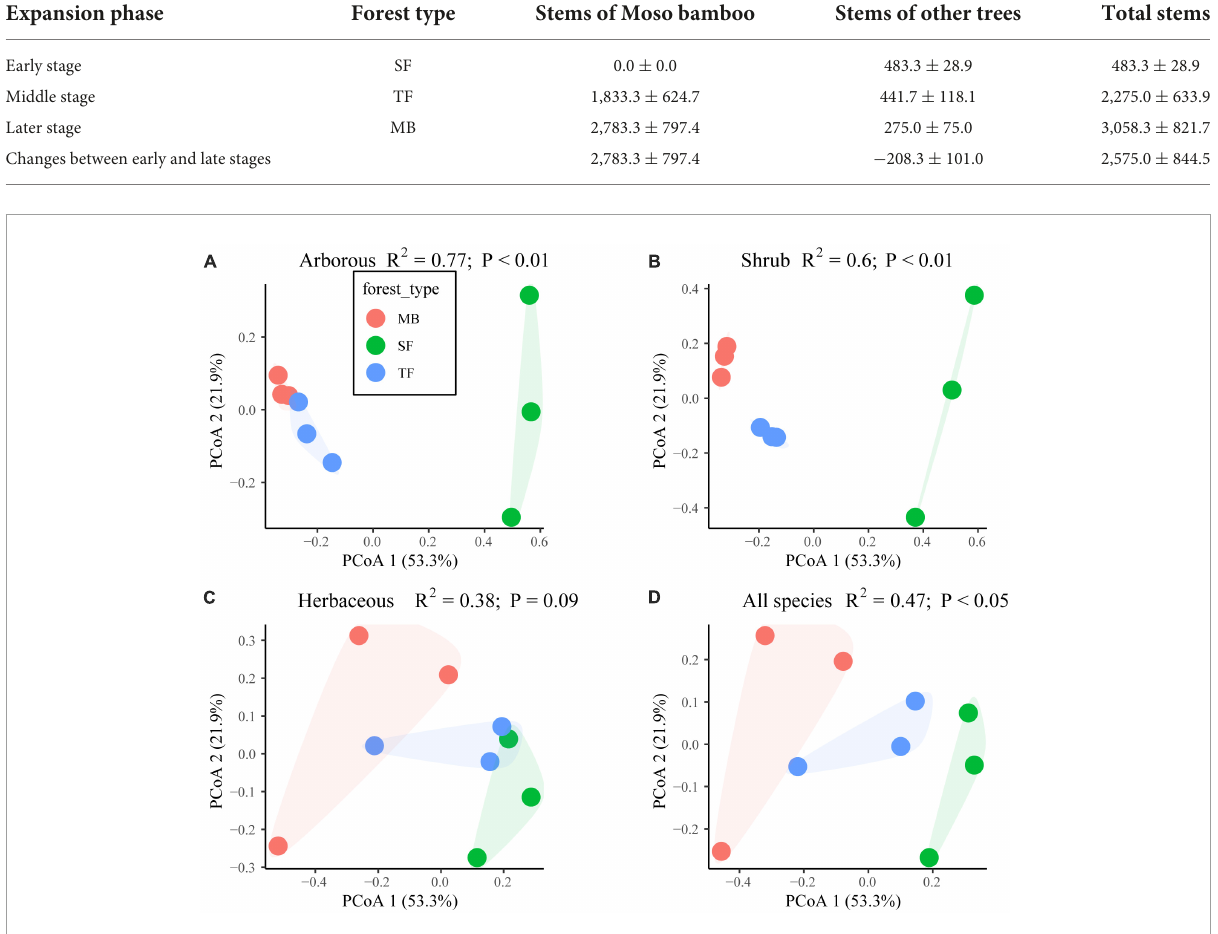
FIGURE1 Effect of the Moso bamboo invasion on species composition difference of each layer among the three forest types [Moso bamboo forest (MB), transition tree-Moso-bamboo forest (TF), and secondary coniferous and broad-leaved mixed forest (SF)] in (A) arborous, (B) shrub, (C) herbaceous layers, and (D) the compound layers with all arborous, shrub, herbaceous species. Significant differences examined with PerMANOVA (permutational multivariate ANOVA) are indicated by P < 0.05 or 0.01. PCoA means principal co-ordinates analysis. PCoA1 and PCoA2 in the figures represented two components of PCoA with largest explaining power to the variation of the species composition